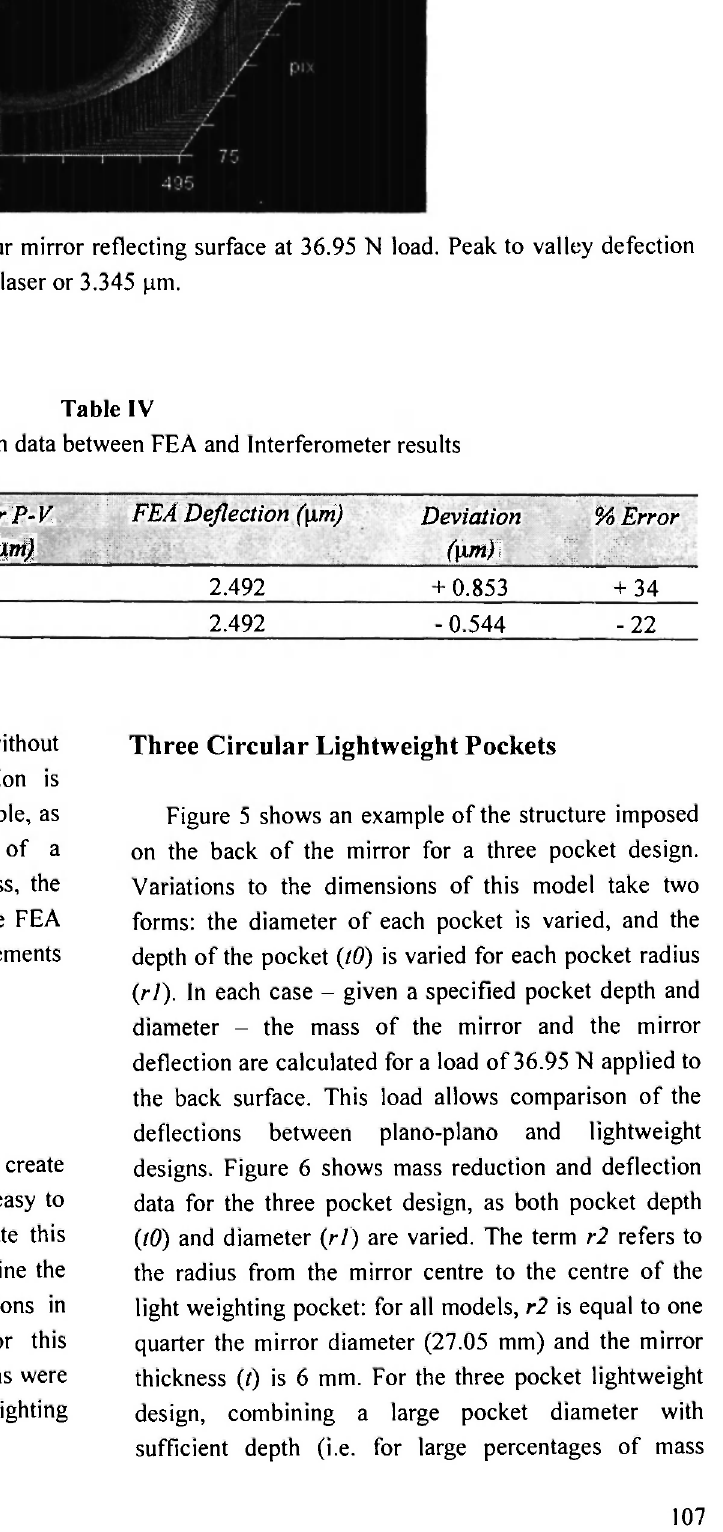
Comparison of deflection data between FEA and Interferometer